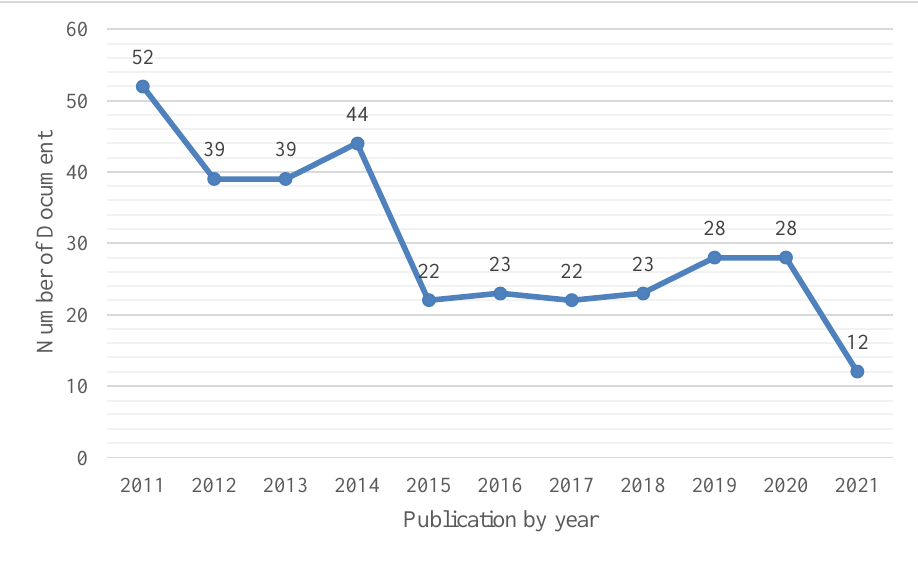
Figure 2: Publication Trend on Interoperability E-Government by Years. Source: Scopus